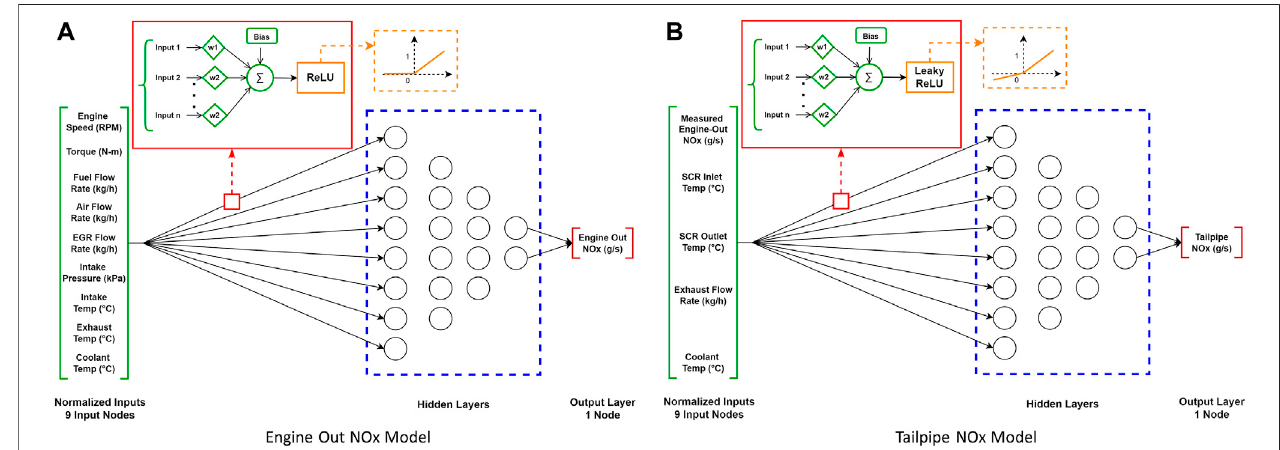
FIGURE 2 | Deep neural network model architecture, inputs/outputs, and activation functions. (A) Engine Out NOx Model. (B) Tailpipe NOx